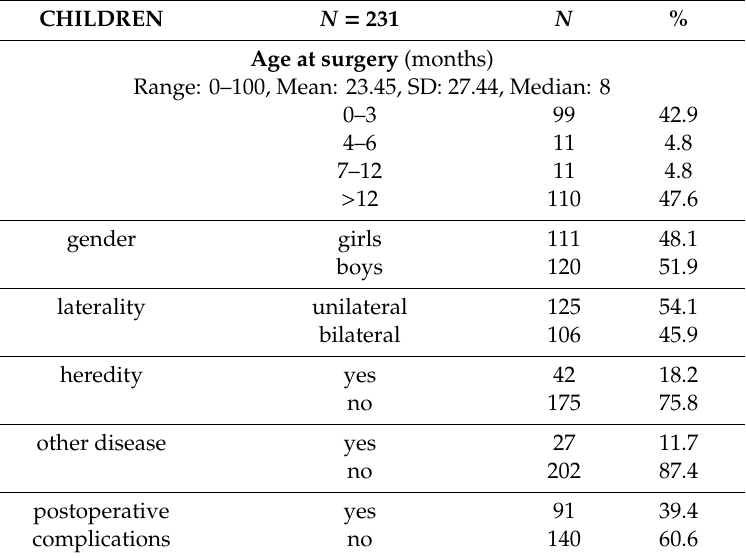
Table 2. Scores from sense of coherence (SOC), Multidimensional Fatigue Inventory Scale (MFI-19),